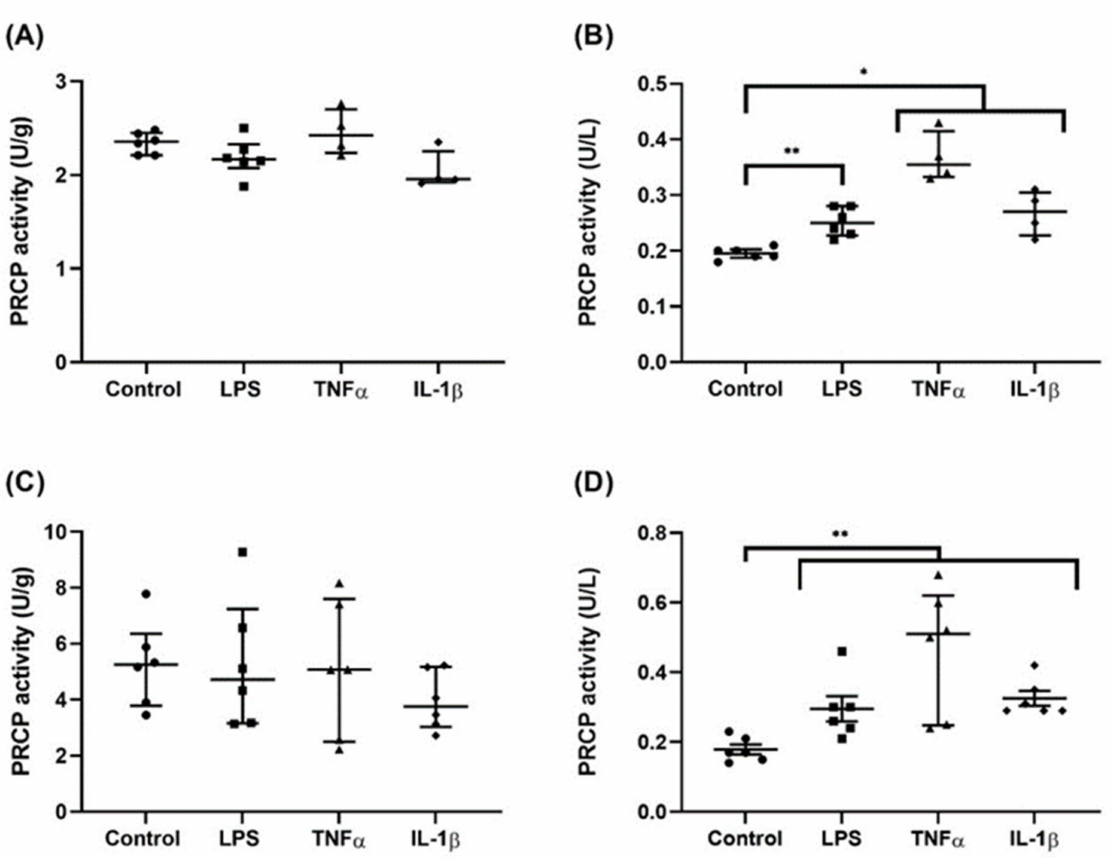
Figure 9. Stimulation with pro-inflammatory agents revealed an increase in PRCP activity in the supernatant of HUVEC and HAoEC. PRCP activity (U/g or U/L) in the cell lysate (( A ) HUVEC and ( C ) HAoEC) and supernatant (( B ) HUVEC and ( D ) HAoEC) of endothelial cells after treatment with vehicle control, LPS, TNF α or IL-1 β measured with a validated RP-HPLC assay. Results are reported as Median ± IQR. ( n = 4–6; * p < 0.05, ** p < 0.01, Kruskal-Wallis and Mann-Whitney